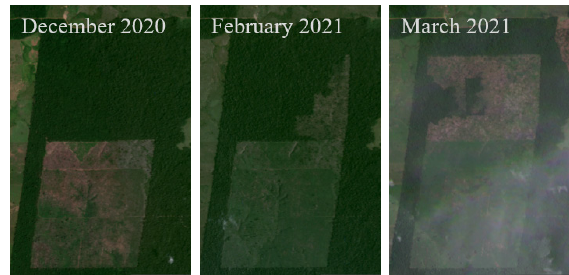
Figure 11. Snippet of ongoing deforestation processes.